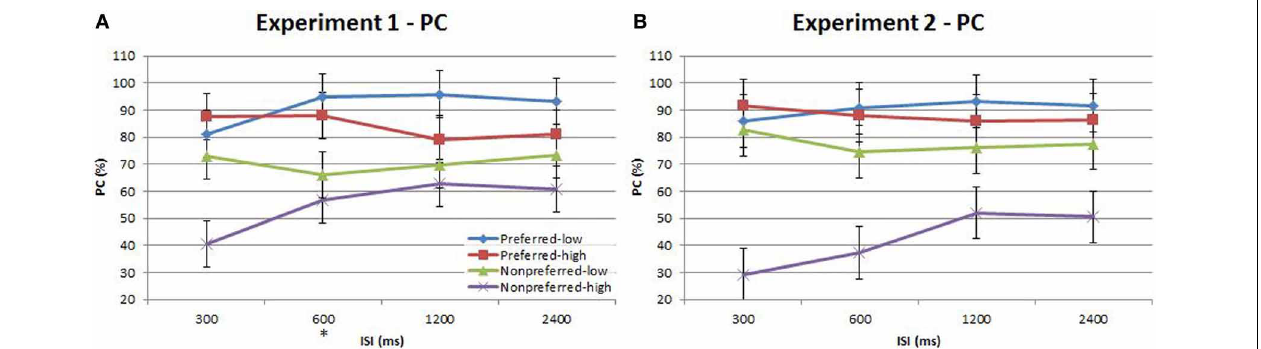
FIGURE 5 | Proportion correct (PC) of time-order/frequency trial-types across the four ISIs. (A) Experiment 1. (B) Experiment 2. Experiment 2 plot shows below-chance proportion correct toward the nonpreferred-high trials, consistent with the perception of the “opposite direction” (see text